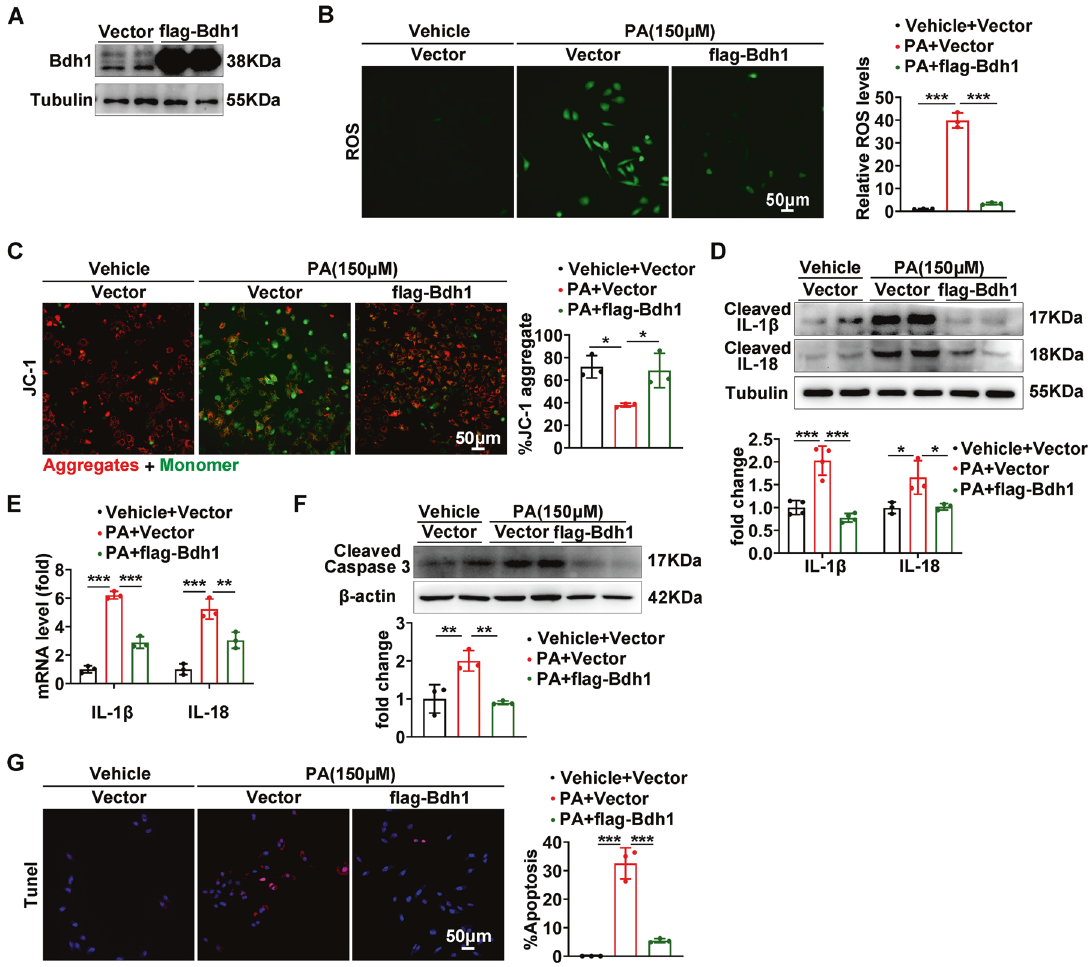
LO2 cells with indicated treatment. Bar: 50 μ m in upper panels and 100 μ m in lower panels. Before ROS assay, LO2 cells were transfected with the plasmids overexpressing fl ag-Bdh1 or vector for 24 h, and then treated with vehicle or PA for 24 h. C JC-1 staining showing